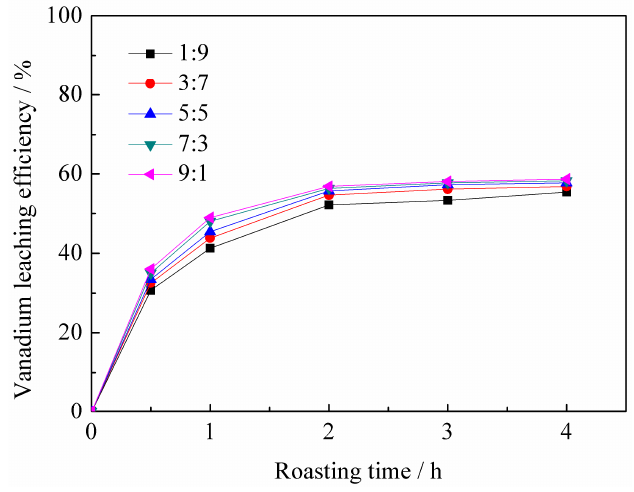
Figure 4. Effect of mass ratio of BaCO 3 to CaO on vanadium leaching efficiency.